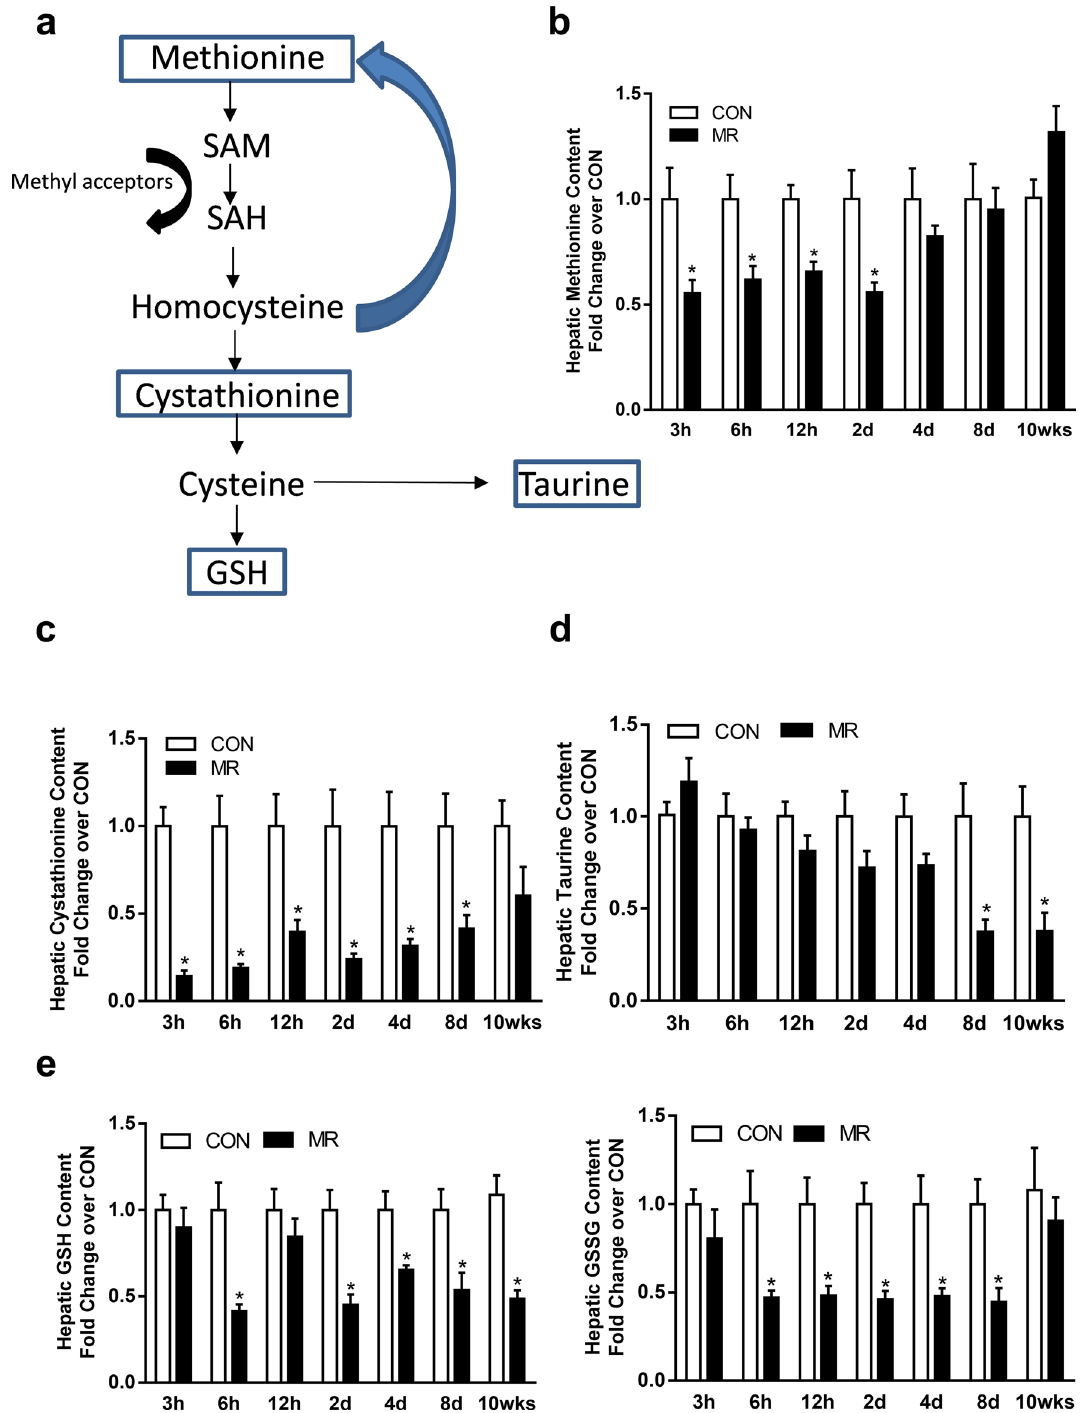
Figure 1. Schematic presentation of methionine metabolism ( a ). Hepatic methionine ( b ), cystathionine ( c ), taurine ( d ), GSH and GSSG ( e ) were measured using metabolomics analysis of mice exposed to Con or MR for 3 h, 6 h, 12 h, 2 days, 4 days, 8 days, and 10 weeks. Data were obtained from n = 8/group and compared between Con and MR for each time point using t-test *p < 0.05. Data are presented as fold induction from Con at each time